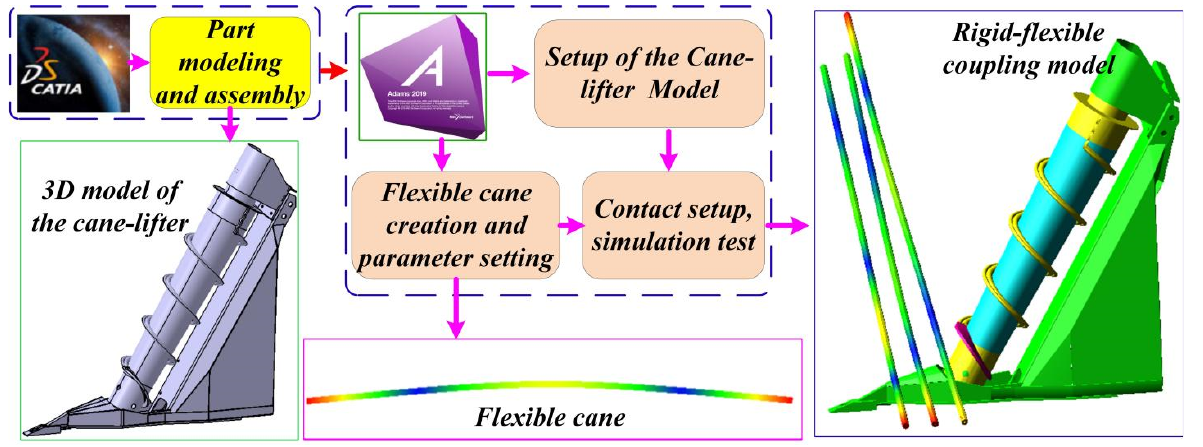
Figure 5. Rigid-Flexible Coupling Simulation Model. Table 1. Types and values of simulation model parameters.